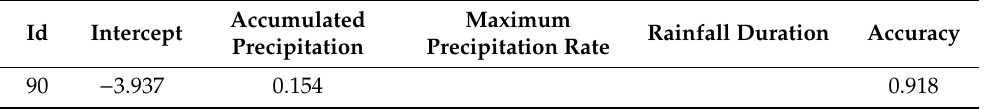
Table A5. Logistic regression model coe ffi cients for the one variable included accumulated